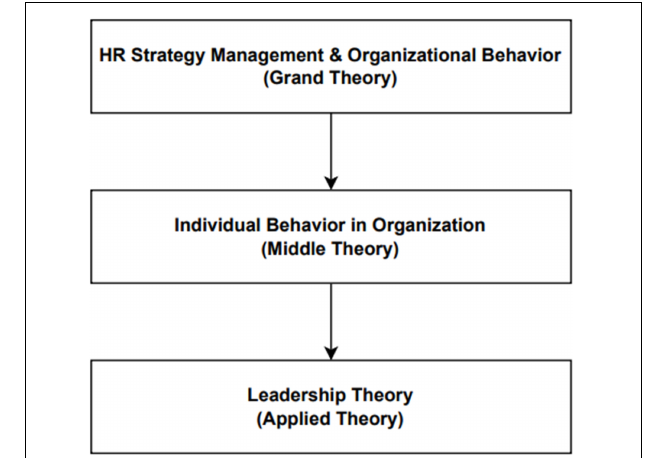
FIGURE 1 | Theory of